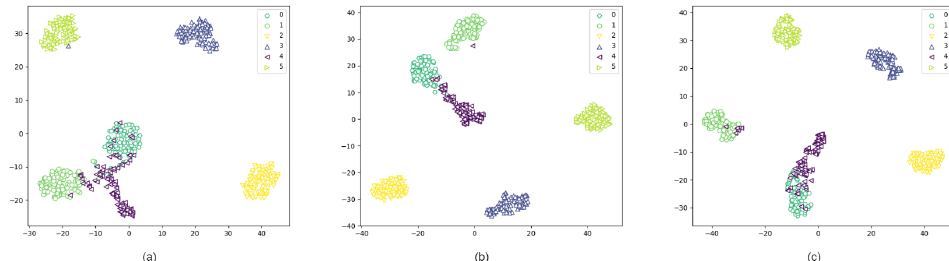
Figure 14. Features visualization via t-SNE for the proposed method at working conditions ( a ) D, ( b ) E, ( c )